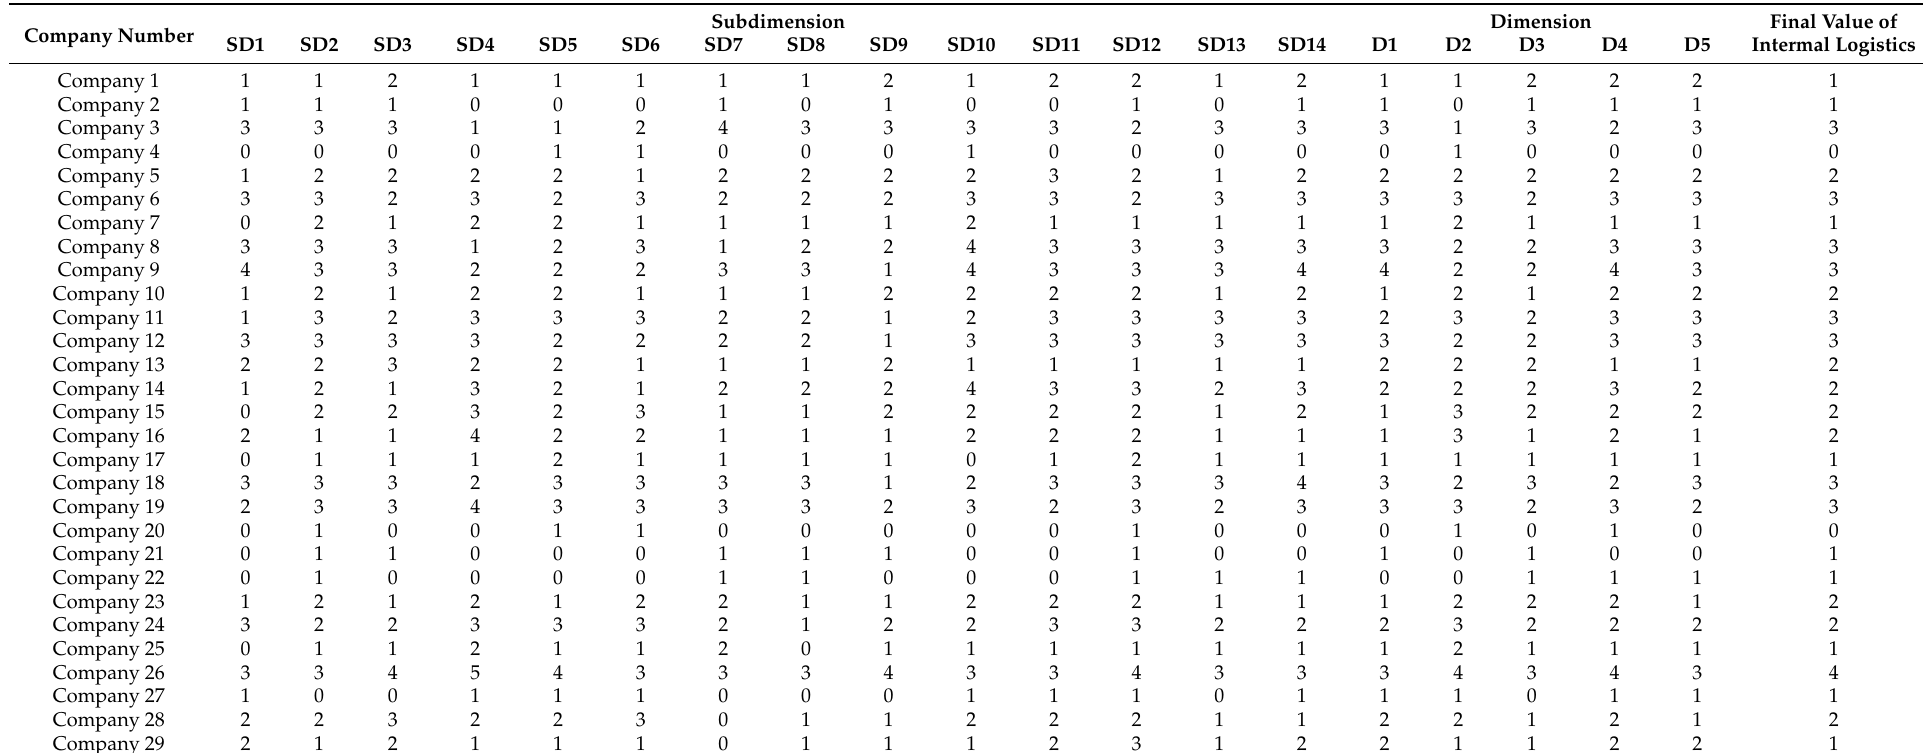
Table A3. Value of the pointer, subdimension, and dimension, then the value of the whole area of internal